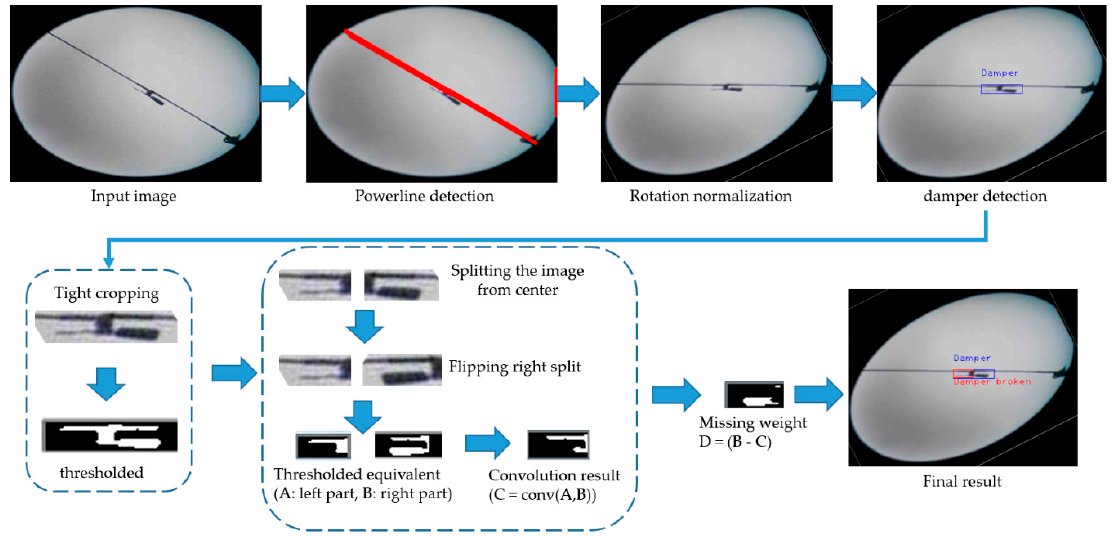
Figure 10. Schematic of the broken vibration damper detection algorithm.